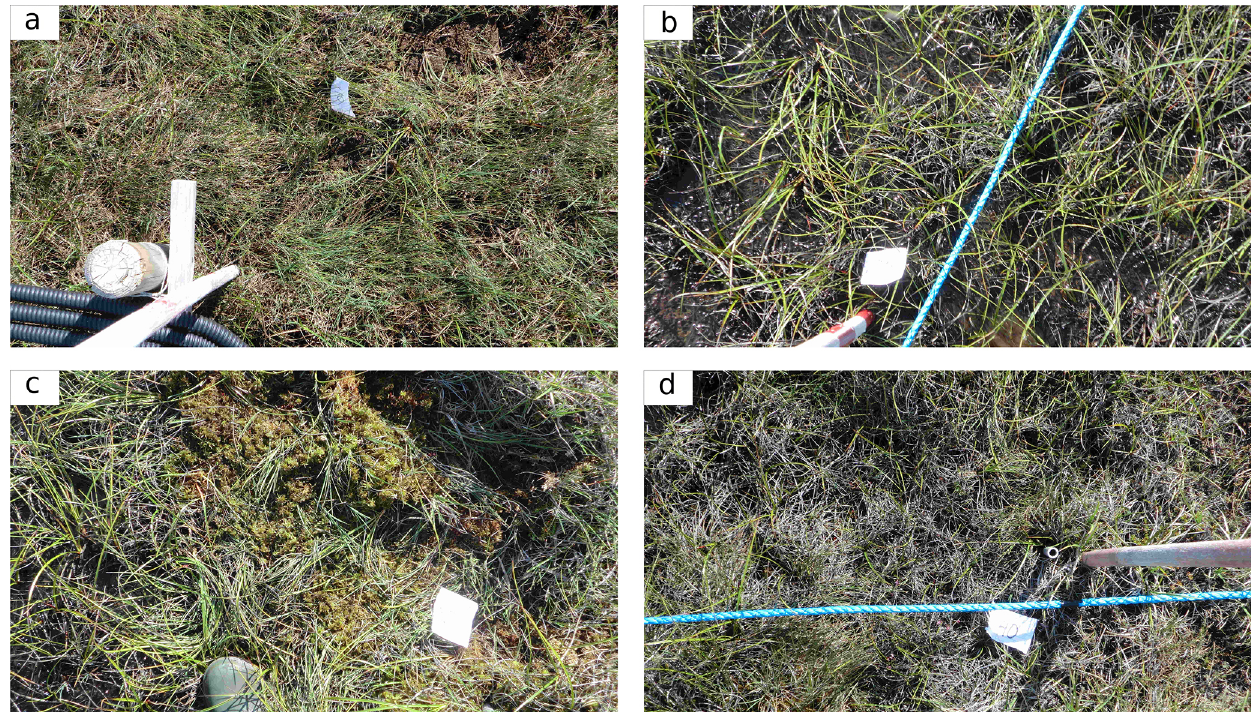
Figure 2. Soil surface photographs along the first transect at several plots. (a) T1–10; (b) T1–30; (c) T1–35; (d)